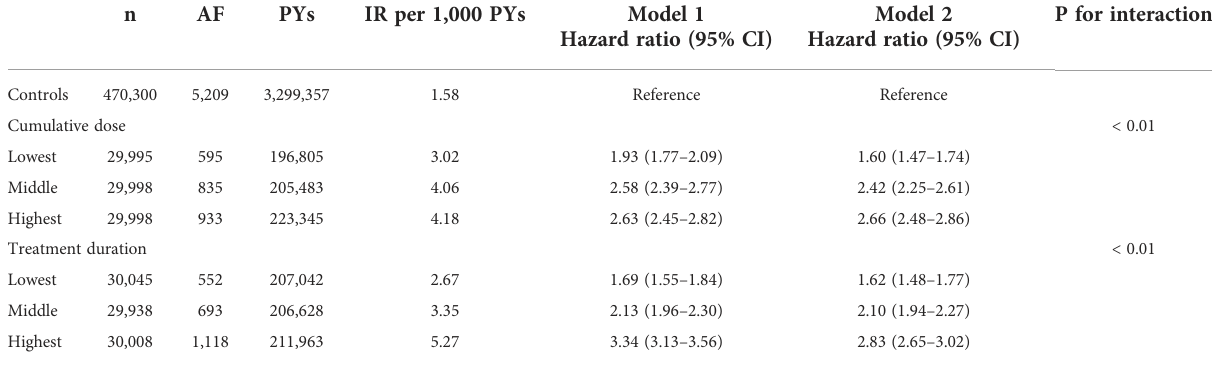
TABLE 4 Risk of atrial fi brillation among patients with Graves ’ disease according to cumulative dose and treatment duration of anti-thyroid drug.